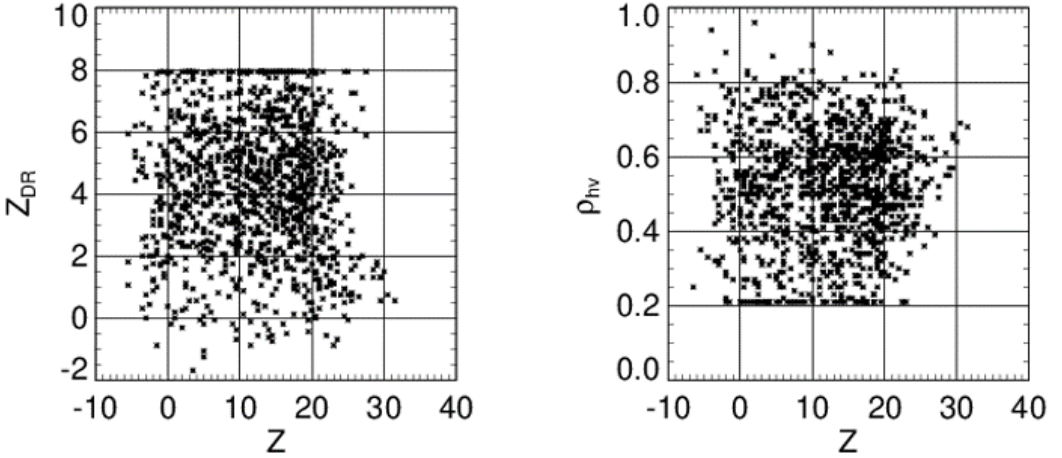
Figure 16. Scattergrams: (left ) of Z DR , Z , and ( right ) ρ hv , Z from the smoke plume in New Mexico. We alert readers that the Z DR of 8 dB is the maximum that is currently possible to record on the WSR-88D (plans are to extend the maximum